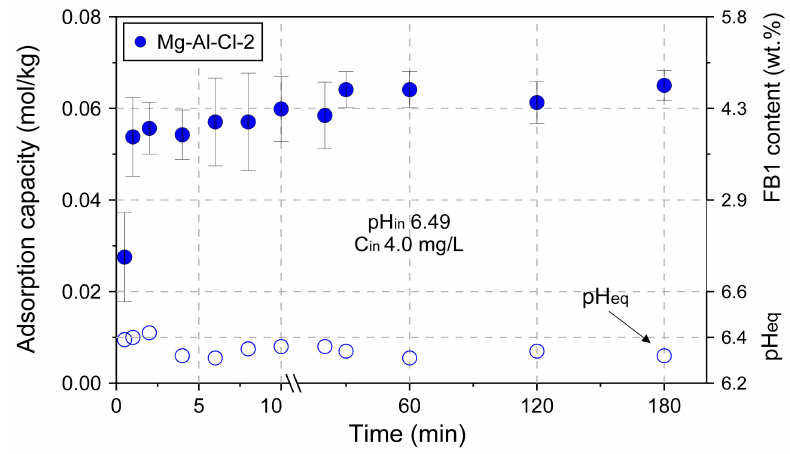
Figure 9. The adsorption kinetics examined for the Mg-Al-Cl-2